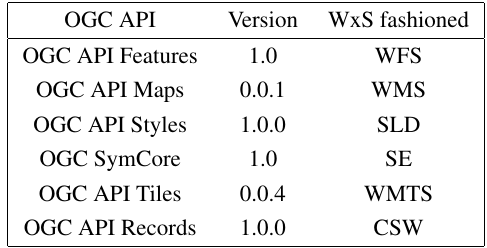
Table 2. From WxS family to OGC